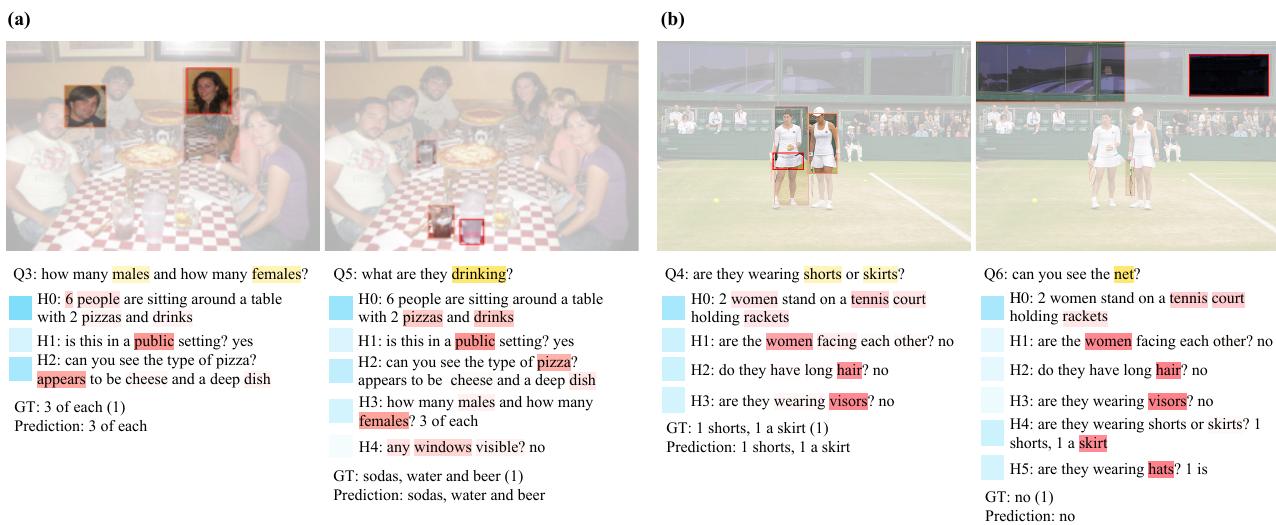
Figure 5. Qualitative results on the VisDial v1.0 validation set. We visualize the different attention scores for each module: (1) Attention scores from Topic Aggregation module and Context Matching module are highlighted in red and blue, respectively; (2) semantic intent of the current question represented via the topic-view alignment step in yellow; and (3) the top three attention scores of visual features from the context-view alignment step, which are represented by the b-boxes with fine adjustment of transparency in the given image. The numbers in the brackets indicate the rank of the correct answer that our model predicts. Darker colors indicate higher attention scores. More qualitative results are described in Appendix